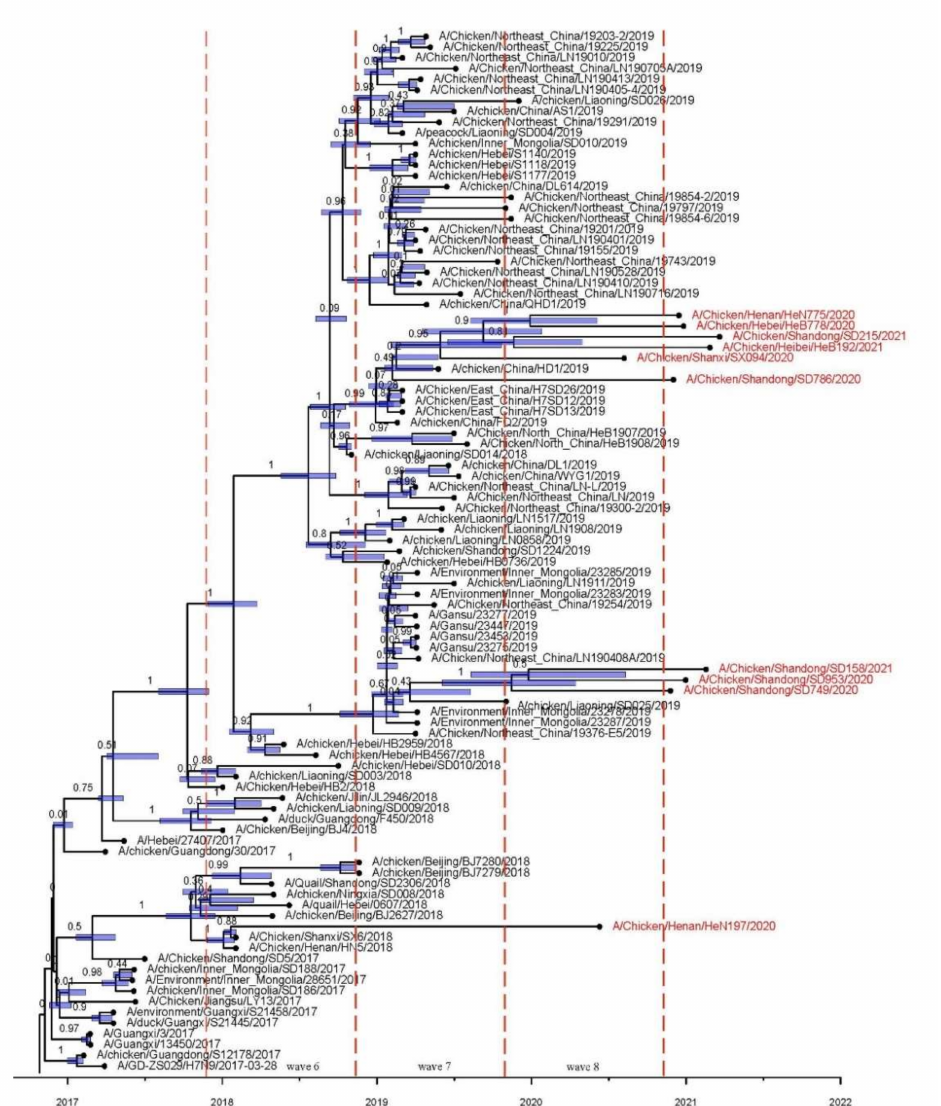
Figure 3. Time-resolved maximum clade credibility (MCC) tree of HA genes. Posterior values are displayed on the tree branches. The internal node highlighted in blue indicates 95% HPD of tree height. The tips of the phylogenetic tree colored in red indicate viruses isolated in our laboratory from October 2019 to April